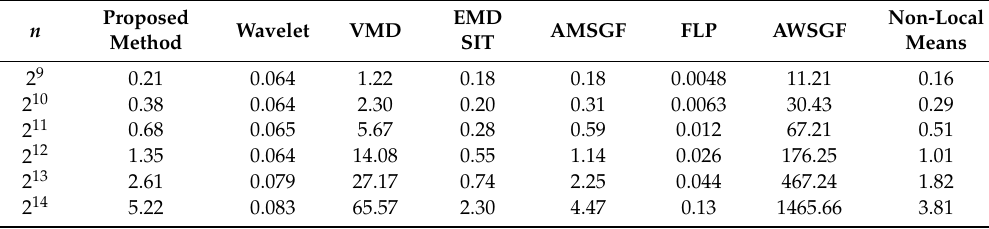
Table 4. Execution time